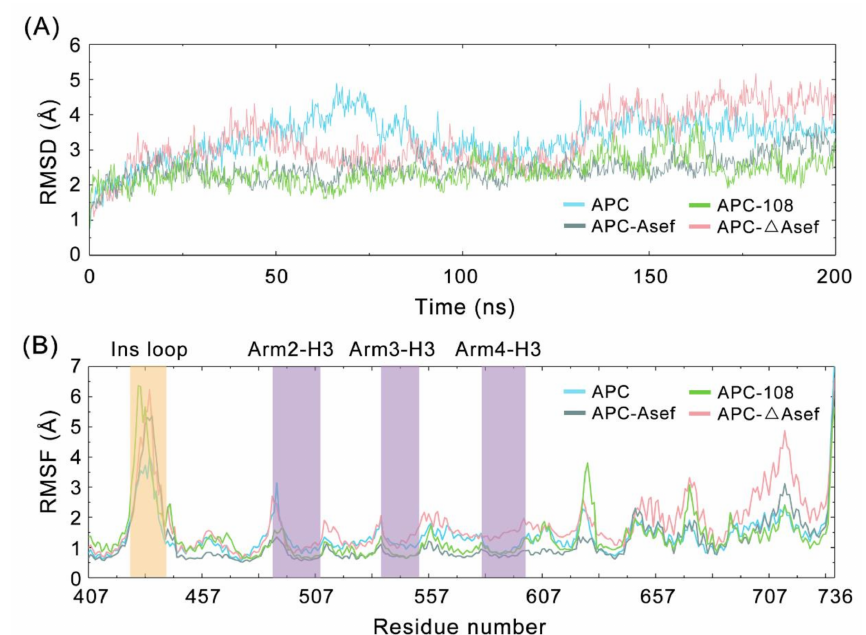
Figure 5. ( A ) The C α RMSDs of APC residues along the whole MD trajectories for APC (blue), APC-108 (green), APC-Asef (gray), and APC- ∆ Asef (pink), referred to the starting structure. ( B ) RMSFs of APC C α atoms for APC (blue), APC-108 (green), APC-Asef (gray), and APC- ∆ Asef (pink) systems. Yellow and purple rectangles represent a highly fluctuated domain and major ligand- binding domains, respectively.